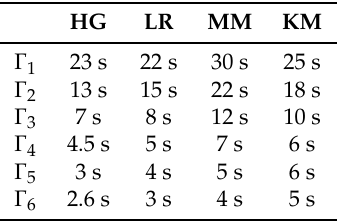
Table 3. Relative Deadlines (seconds) of the Task Sets ( Γ 1 – Γ 6 ).